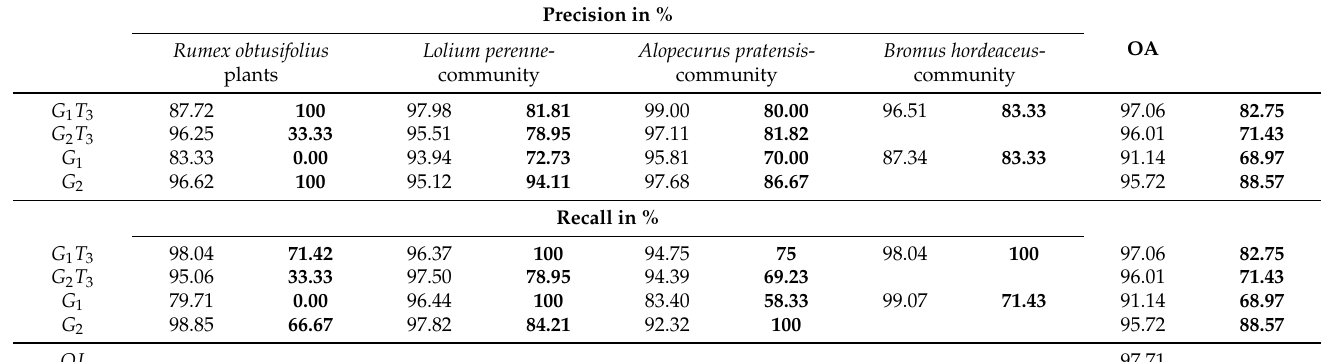
Table 3. Precision, recall, and overall accuracy (OA) (in %) for dependent and independent test data of the four vegetation classifications for Rumex obtusifolium plants, the Lolium perenne -, Alopecurus pratensis -, and Bromus hordeaceus -community and overall accuracy for the object identification (OI). Precision in %